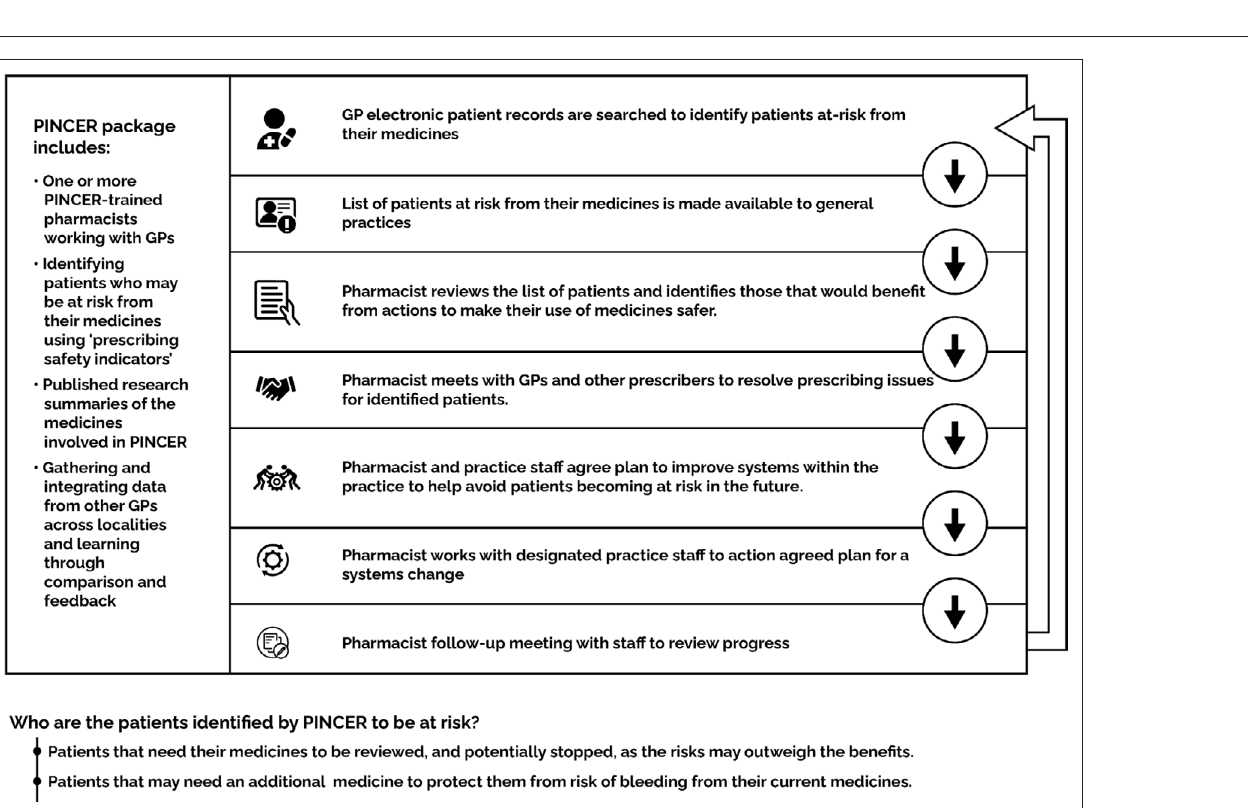
Figure 1 Summary of pharmacist- led IT- based intervention (PINCER) in general